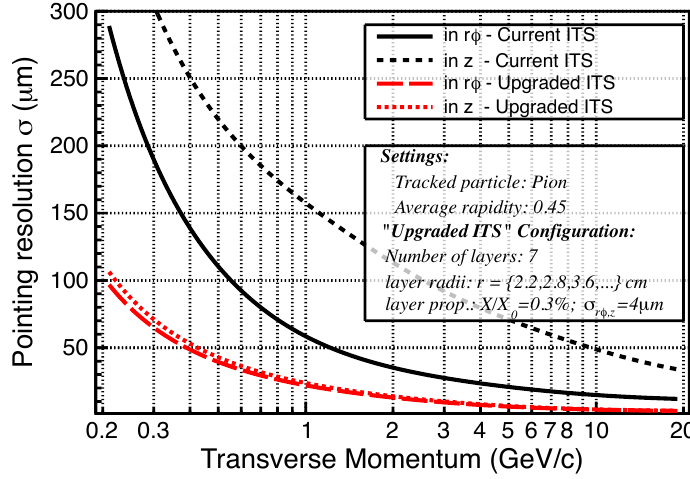
Figure 1. Track impact parameter resolution in r φ and z for the current (black) and upgraded (red) ITS.